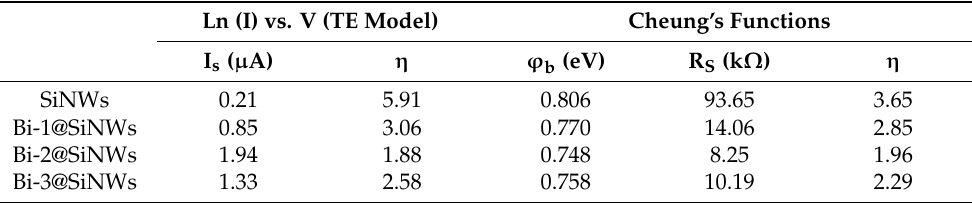
Table 1. Electrical parameters determined by conventional TE and Cheung’s model.